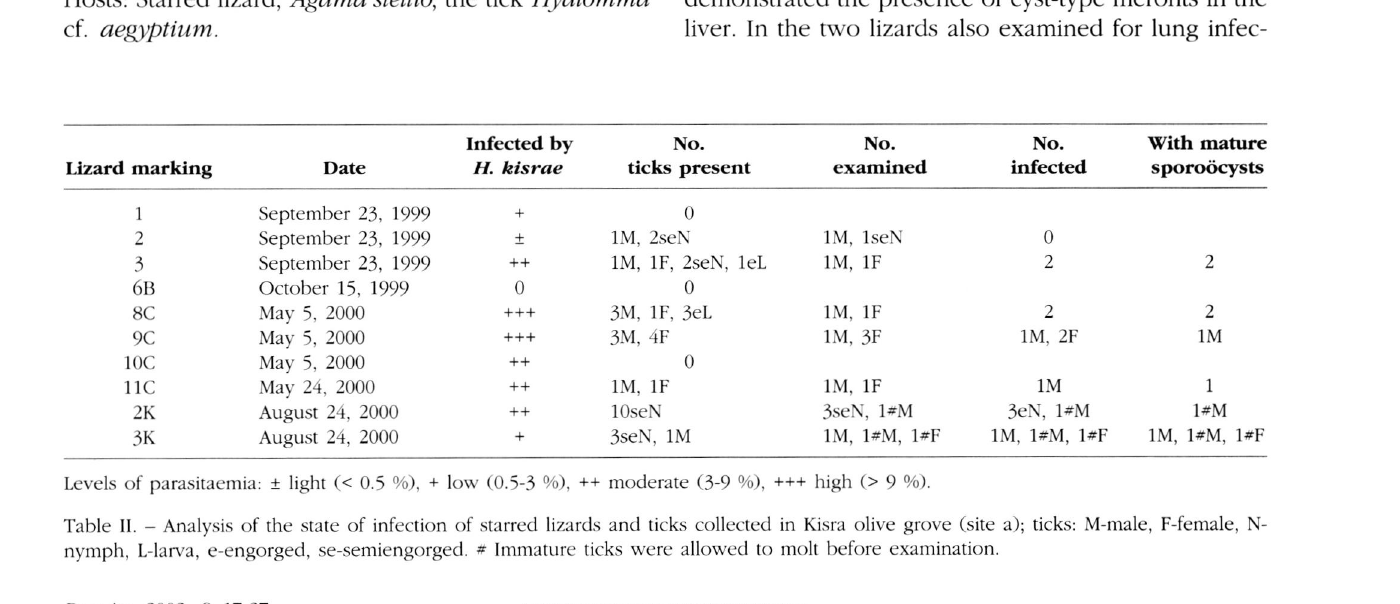
Parasite, 2002, 9,